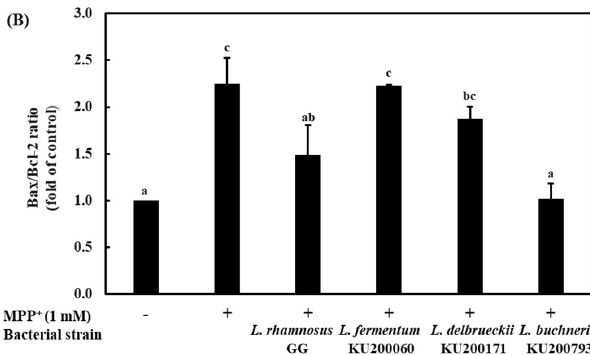
Figure 3. mRNA expression of ( A ) BDNF and ( B ) apoptosis-related genes (Bax / Bcl-2 ratio) in SH-SY5Y cells using RT-PCR. L. rhamnosus GG, CM of heat-killed L. rhamnosus GG; L. fermentum 200060, CM of heat-killed L. fermentum KU200060; L. delbrueckii 200171, CM of heat-killed L. delbrueckii KU200171; and L. buchneri 200793, CM of heat-killed L. buchneri KU200793. All values are mean ± standard error of triplicate experiments. Di ff erent superscript letters on each bar represent significant di ff erences ( p <